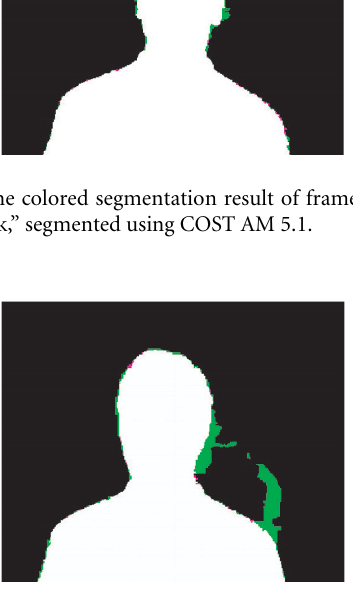
Figure 15: The colored segmentation result of frame 20 from the sequence “Erik,” segmented using COST AM 5.0.